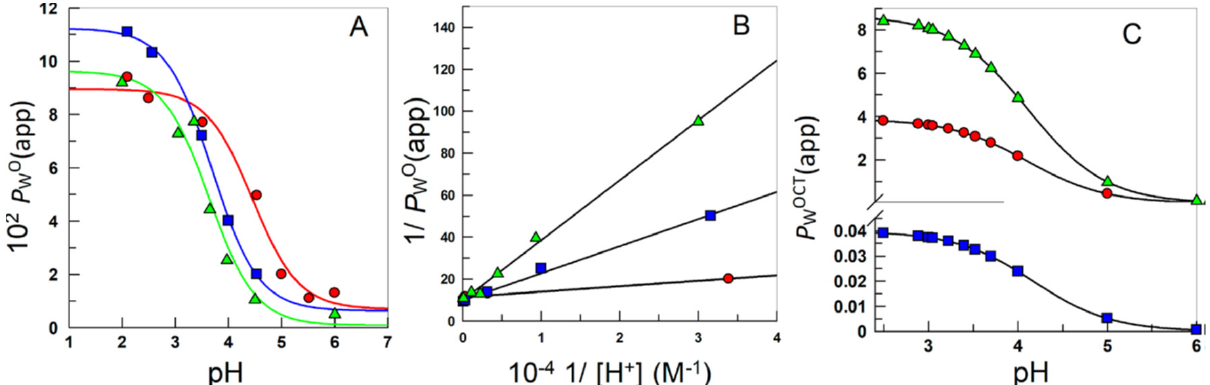
Figure 8. Experimental and theoretical variations of the apparent partition constants of ionizable antioxidants (gallic acid( ● ), ascorbic acid ( ■ ), and ca ff eic acid ( ▲ )) with the acidity (pH) of the aqueous phase in olive oil − water ( A ) and linear plots of 1/ P WO (app) with pH according to Equation (6) ( B ). For the sake of comparisons, in octanol-water ( C ) binary systems. The solid line is the theoretical curve obtained by fitting the experimental data to a sigmoidal Henderson–Hasselbach type (Equation (6)). Simulations are done assuming that the ionization of the antioxidant in the oil phase is negligible. Figure adapted from Freiría et al. [67], with permission, copyright the American Chemical Society.